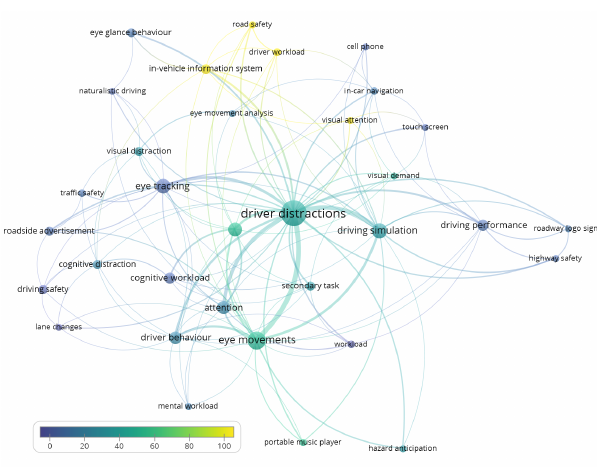
Figure 8. Co-occurrence and citation count of author